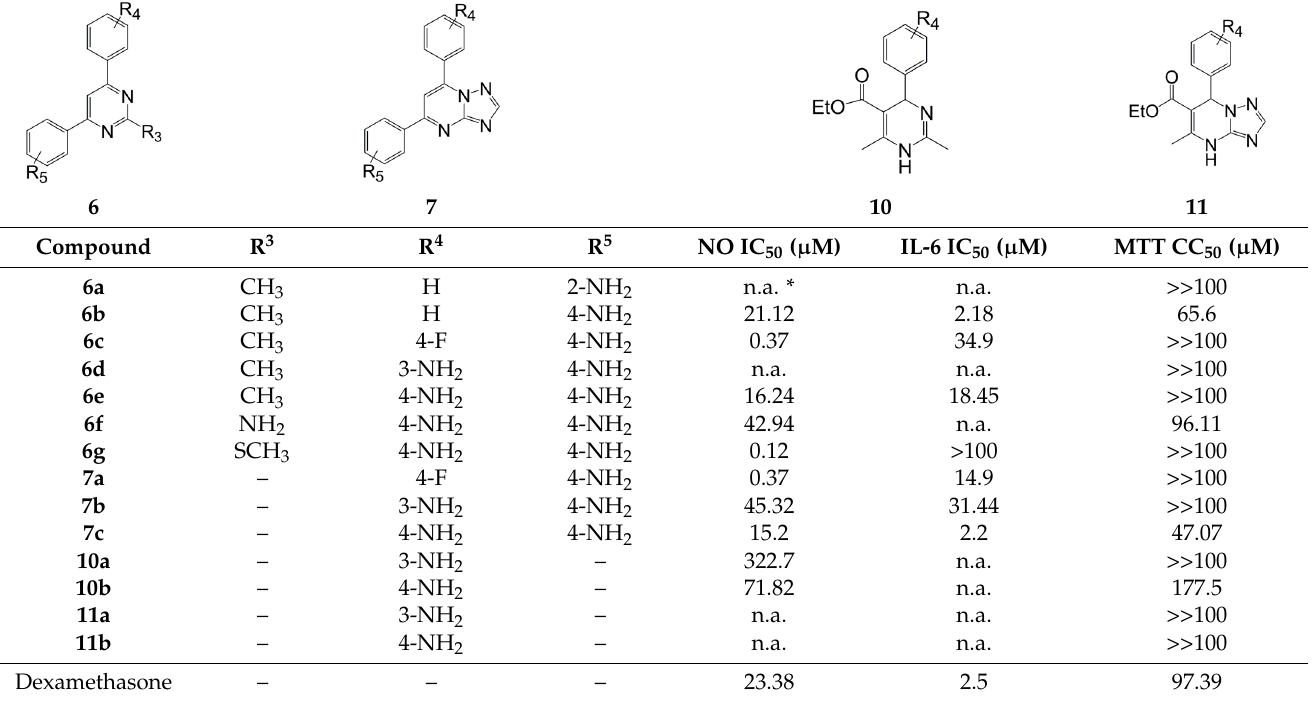
Table 1. Inhibition of NO synthesis and IL-6 release in LPS-stimulated macrophages.